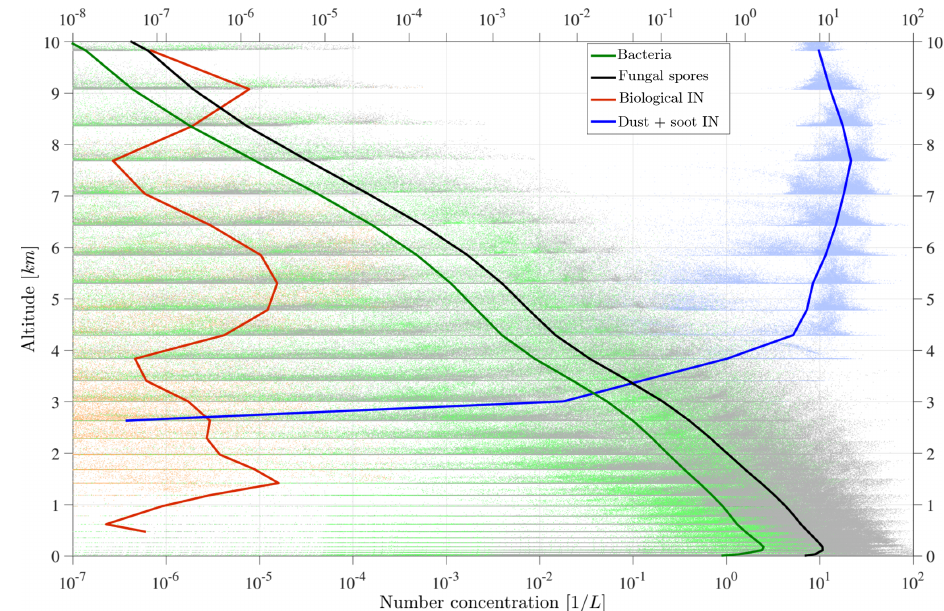
Figure 4. Vertical profile domain-mean concentrations of bacteria, fungal spores, and total PB-INP and background dust and soot INP concentrations for the case study in July 2010. Each scatter cloud represents the entirety of the original data.